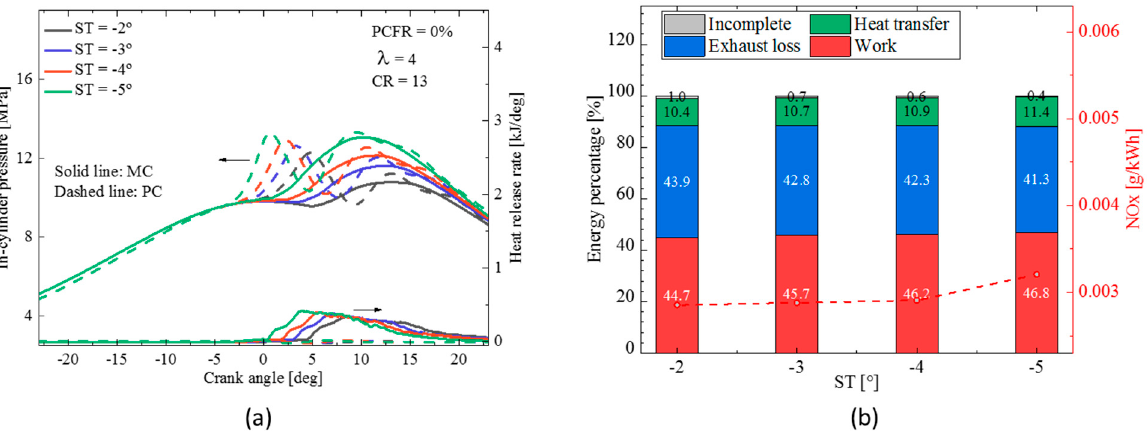
Figure 15. Predicted: ( a ) in-cylinder pressure and heat release rate traces; and ( b ) efficiency for PCFR = 0%, CR = 13, and λ = 4 using different STs.